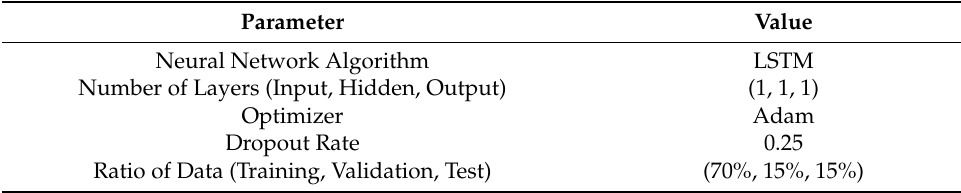
Table 2. Parameters of the LSTM model used to generate synthetic Vp. Parameter Neural Network